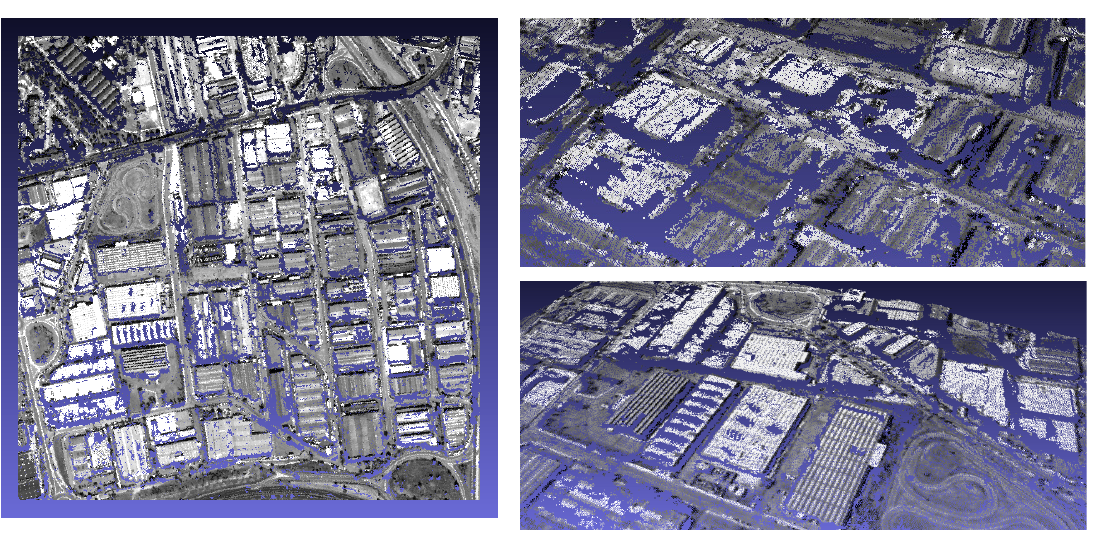
Figure 10. Point cloud of the test area.